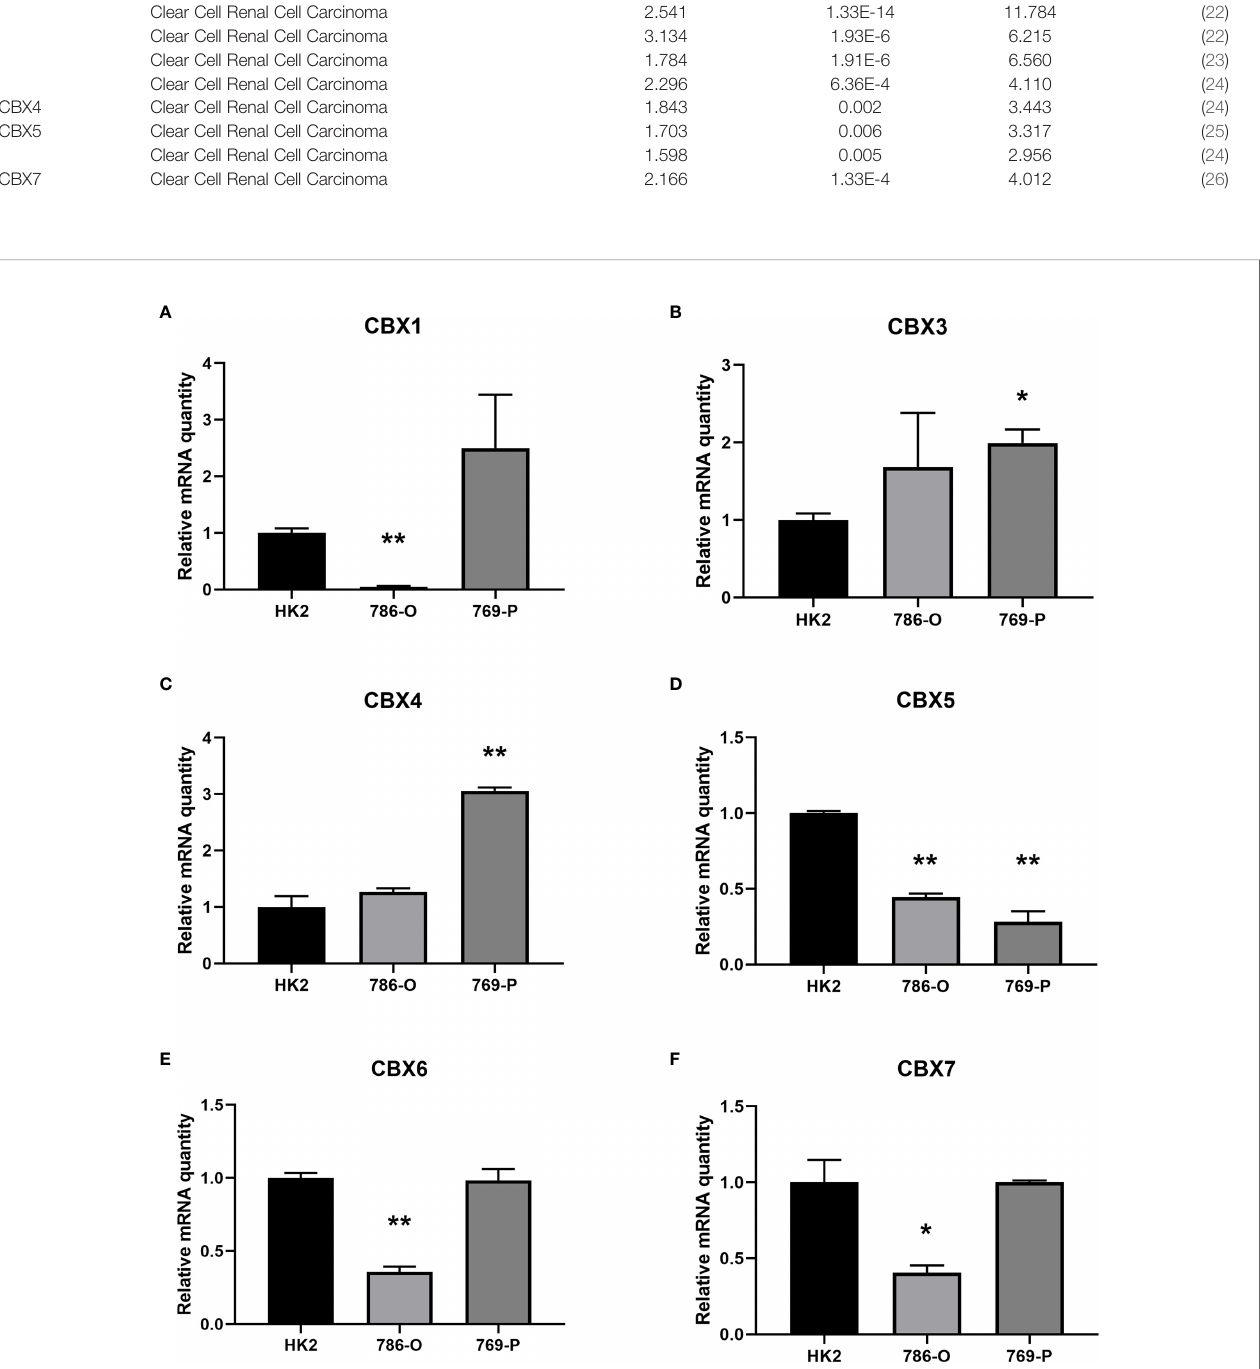
FIGURE 2 | The mRNA levels of CBXs in normal kidney cell and ccRCC cells (qRT-PCR). The mRNA levels of CBX3 and CBX4 in ccRCC cells were signi fi cantly elevated compared with normal kidney cells (B, C) , while themRNA levelsofCBX1, CBX5, CBX6, CBX7were signi fi cantly reduced in ccRCC cells (A,D – F) . (* p <0.05, ** p